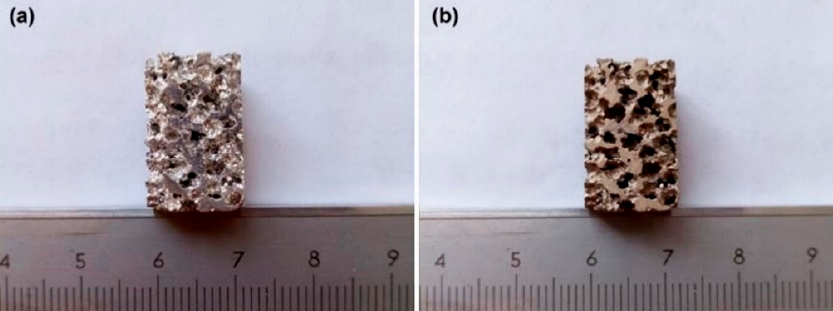
Figure 1. Macroscopic morphologies of ( a ) AZ91D alloy foams and ( b ) AZ91D hybrid foams.